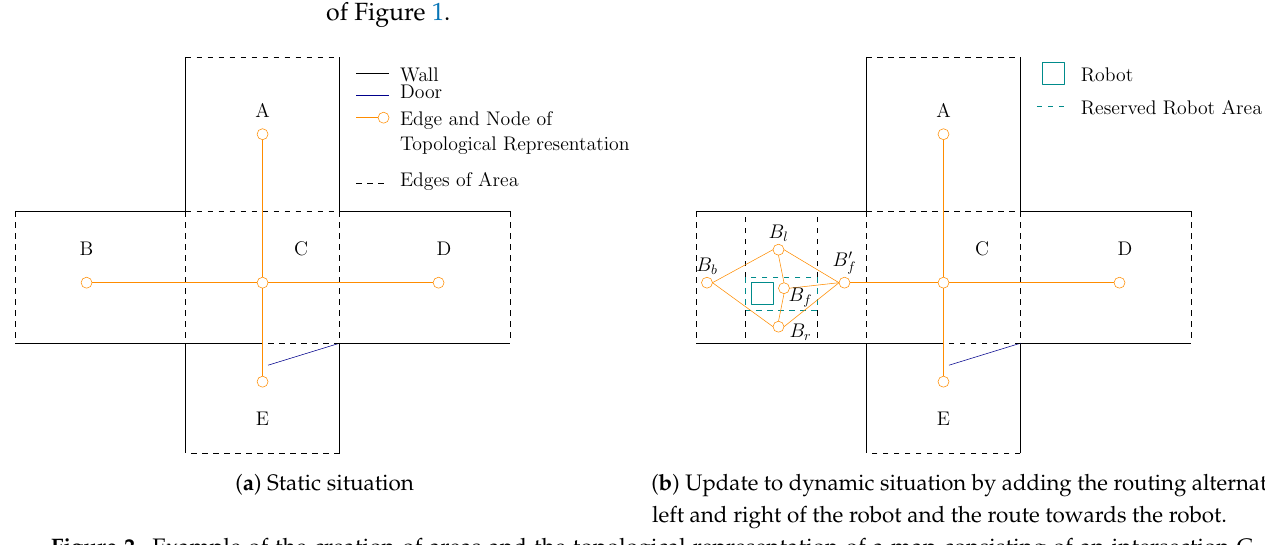
Figure 2. Example of the creation of areas and the topological representation of a map consisting of an intersection C including a doorway and the corridors A, B, D and E connected to this